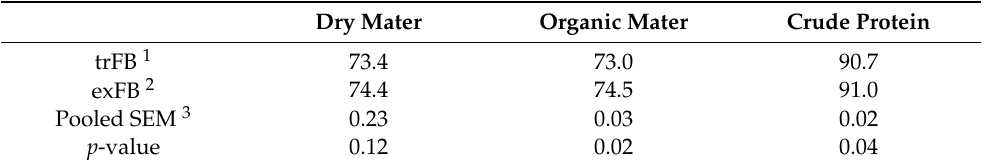
Table 3. Effect of extruding raw field beans on in-vitro digestibility of dry matter (DM),